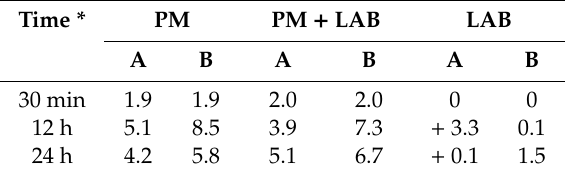
Figure 1. S. aureus germ density for the application of a phage mixture, a lactic acid bacterium and their combination. The S. aureus germ density [log 10 cfu/mL] for 100 µL sample material is given with standard errors. The common mean values of the two S. aureus isolates 7142 and 10614 are given (SEM 5.25 log cfu/mL ± 0.15 SEM) as the statistical calculation showed no significant difference between the two S. aureus isolates ( p > 0.05). * Time of incubation at 37 °C in ultra-high temperature (UHT) milk. PM = phage mixture (STA1.ST29; EB1.ST11; EB1.ST27) ( p < 0.05); LAB = lactic acid bacterium (118/37, Lb. plantarum ) ( p > 0.05); PM + LAB = combined application of the phage mixture and the lactic acid bacterium ( p > 0.05). Table 2. Reduction of S. aureus germ density in log 10